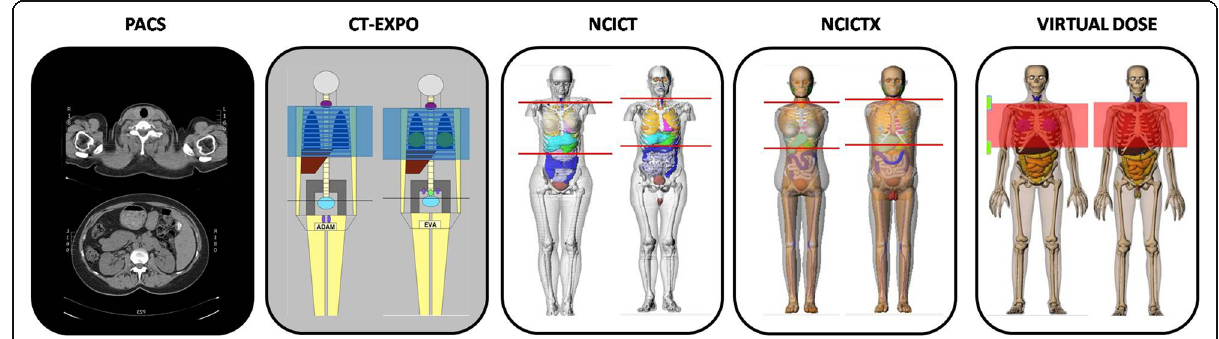
Fig. 1 Examples of scan region on the different phantoms implemented in CT-Expo, NCICT, NCICTX, and Virtual Dose. The region to be set, in this case for a chest study, was defined by selecting images archived in our Picture Archiving and Communication System (PACS). We can see that the anatomical landmarks, used to fix the scan start and end, change according to the phantom used. In particular, CT-Expo phantom lacks anatomical